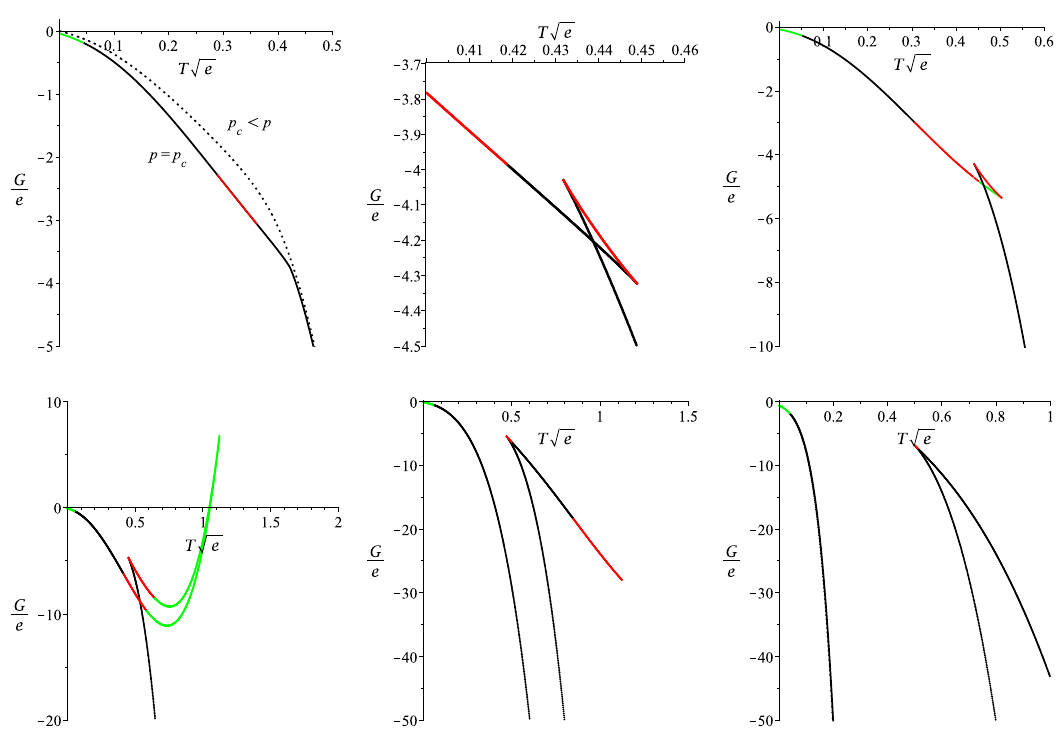
p e (cid:25) 0 : 42157